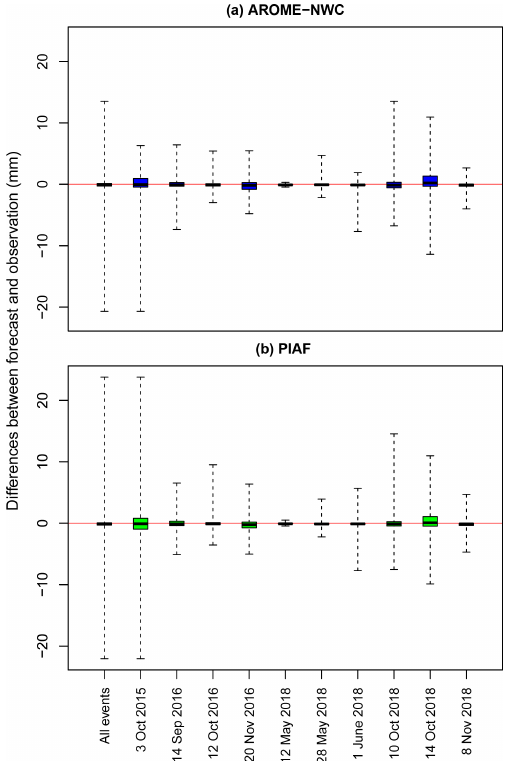
Figure 9. Distributions of average rainfall forecast errors over catchment areas (forecast values – observed values) for (a) AROME-PI (lead times in the range T + 45min to T + 6h), and (b) PIAF (lead times in the range T + 15min to T + 3h) for all events and by event. The lower edge of the boxplots corresponds to the first quartile, the central line to the median and the upper edge to the third quartile of the values taken by these errors (the whiskers go up to the extreme